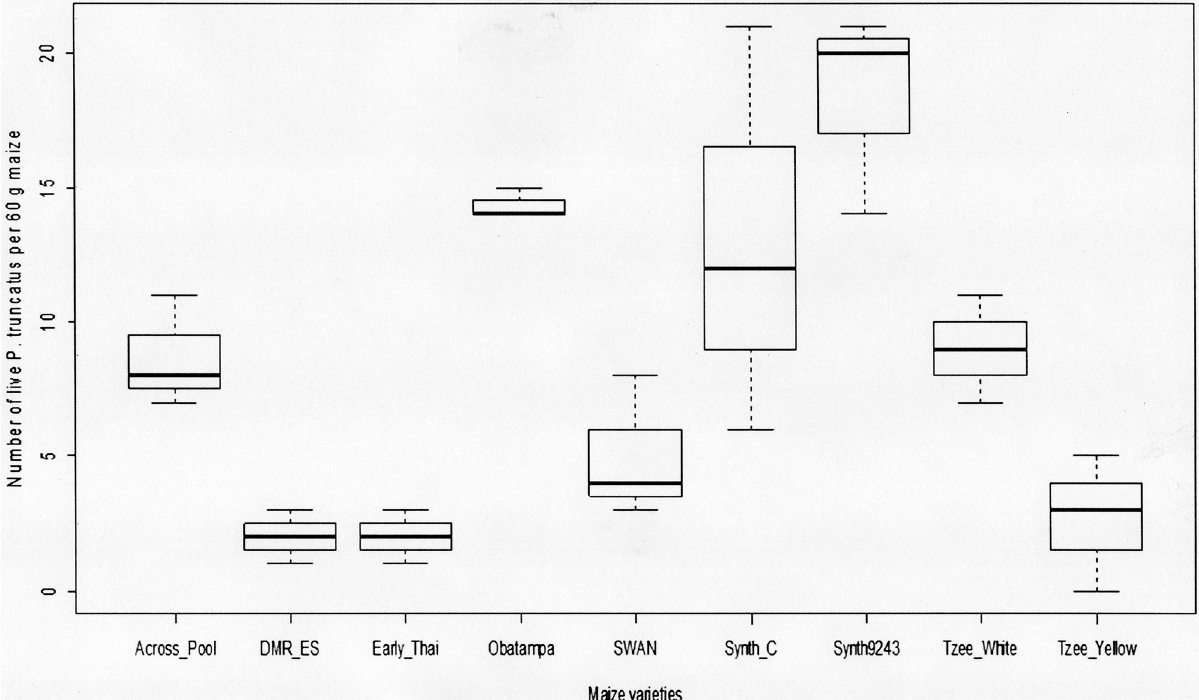
Fig 1. Number of F 1 P . truncatus progeny emerged on 60 g grains. Number of F 1 P . tuncatus progeny emerged on 60 g grains of each maize varieties after infestation out under no-choice method for 55 days on laboratory conditions. Overall differences of insects emerged between maize variety are significant at ANOVA test (P <